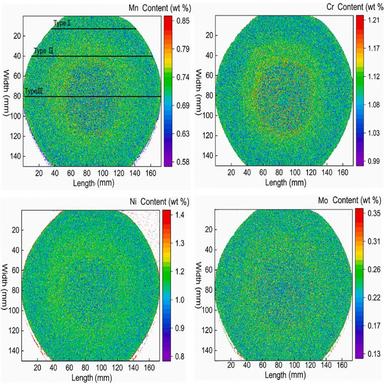
Two-dimensional content distribution by the μ-XRF for A11 sample.